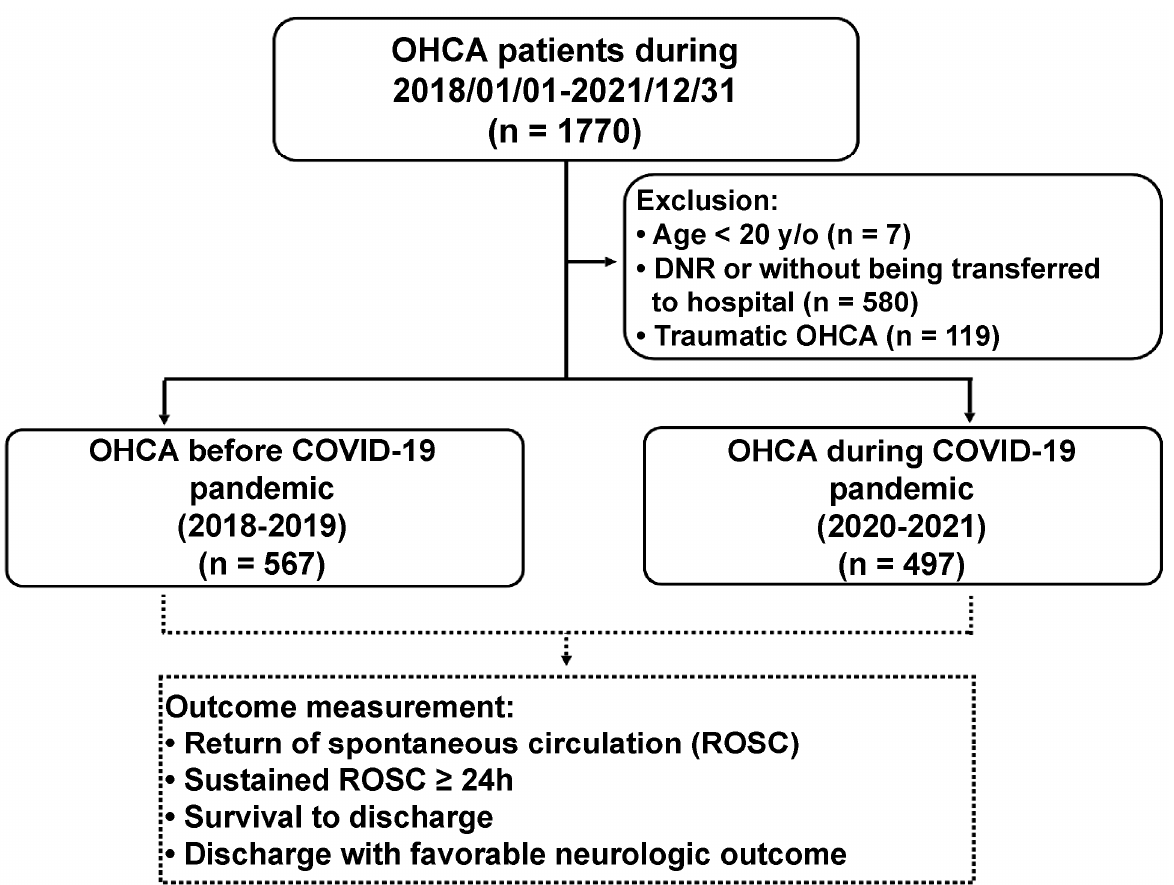
Figure 1. The flowchart of patient selection and grouping in our study.